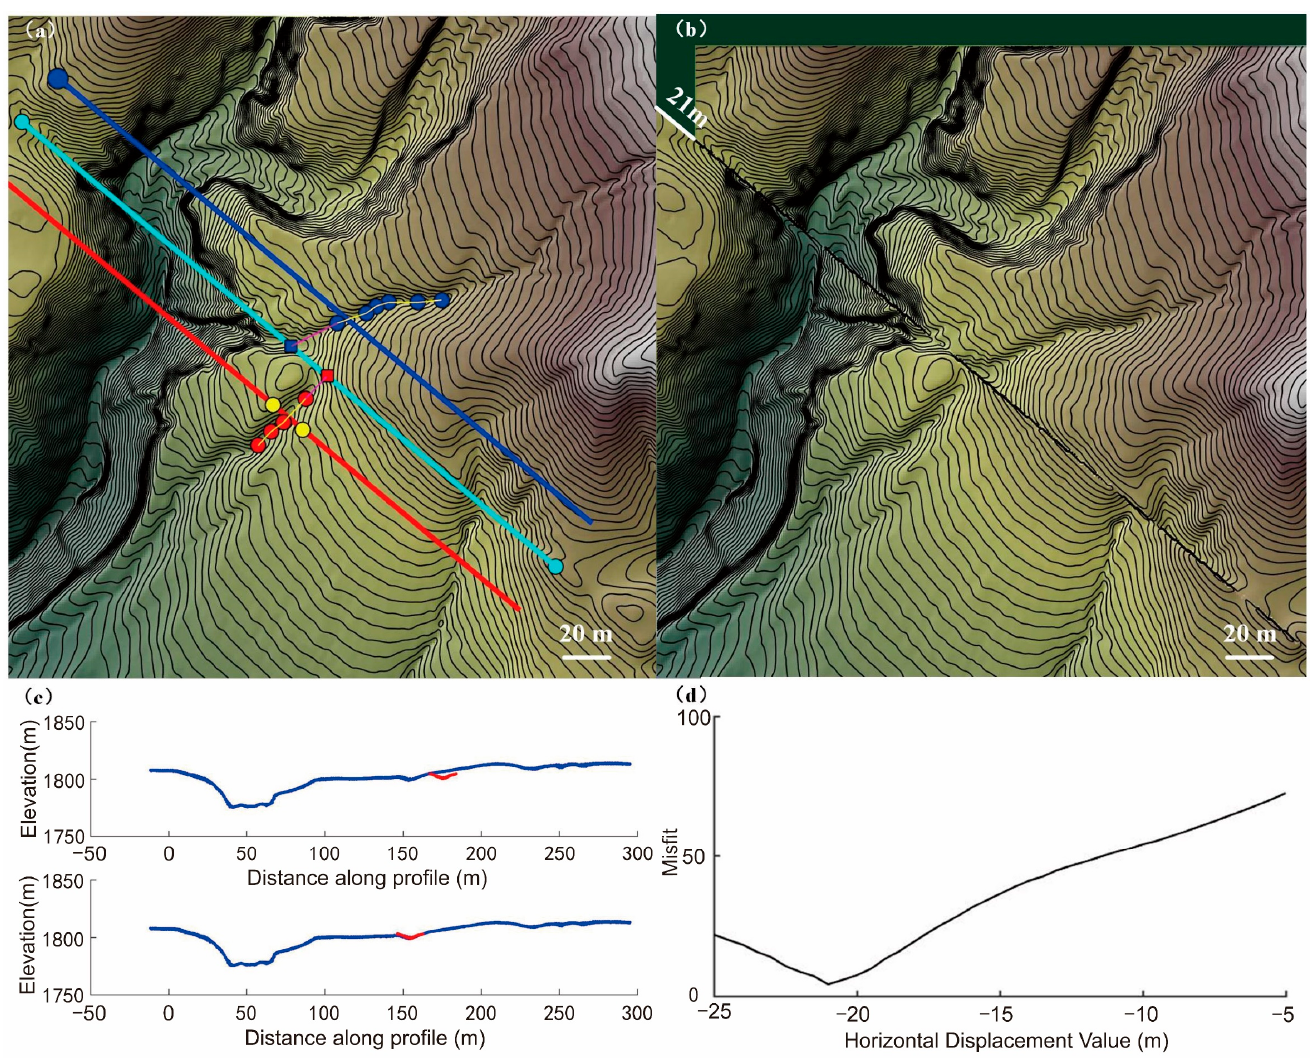
Figure 5. Measurement of the horizontal offsets using LaDiCaoz_v2.1 software. ( a ) The faults (light blue), fault-parallel profile lines (red and blue), and the longitudinal tracking line (yellow) were drawn on the basis of the DEM. ( b ) Dislocation recovery results of the fault. ( c ) The red and blue topographic profile lines were projected onto the fault plane based on the orientation of the gully, and the red and blue profile lines were matched through horizontal movement, vertical movement, and stretching adjustment. ( d ) Evaluation of the matching results of the horizontal offsets.